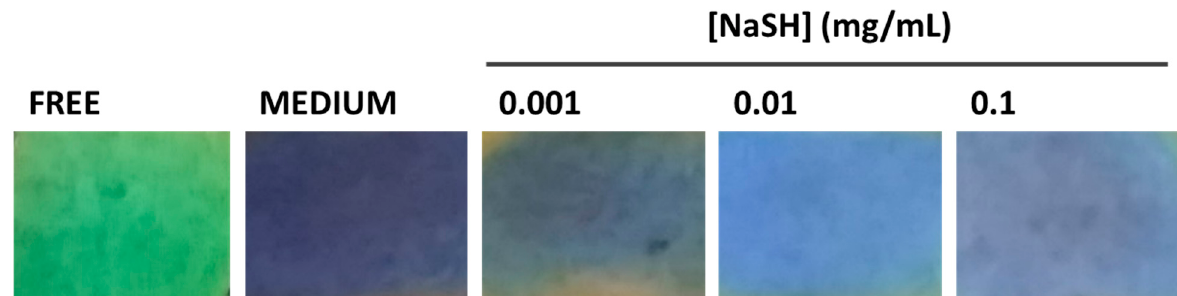
Figure 7. Real color images of a cropped area of complex 5 -loaded paper strips after adding increasing amounts of HS − dissolved in cell culture medium. Non-treated complex 5 -loaded paper strips are indicated as FREE. Complex 5 -loaded paper strip treated with cell culture medium without NaSH (indicated with MEDIUM) is used as a control. Original non-cropped images are reported in SI (Figure S25).